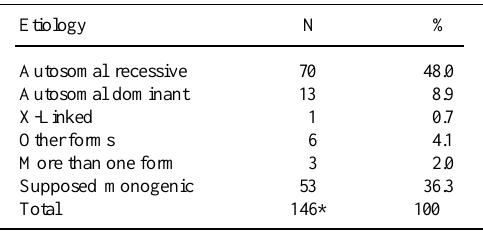
*Corresponds to 64% of the total number of individuals examined.